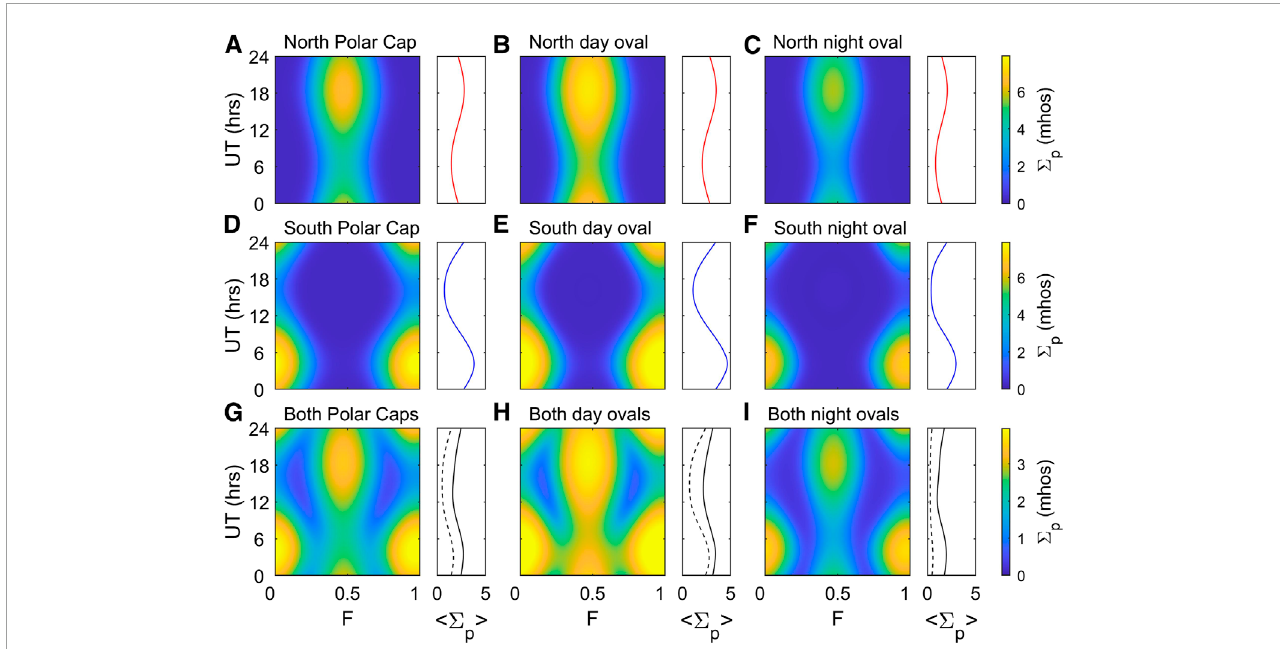
FIGURE 6 Analysis of the effect of pole motions on solar EUV-generated, height-integrated ionospheric Pedersen conductivity, computed using the dependence on solar zenith angle by Ridley et al. (2004) and the eccentric dipole model of Earth’s magnetic field by Koochak and Fraser-Smith (2017) for the year 2016. The variations of mean Pedersen conductivity are color-coded as a function of fraction of the year ( F , horizontal axis) and Universal Time ( UT , vertical axis). To the right of each color plot is a plot of the mean height-integrated Pedersen conductivity ⟨Σ p ⟩ (averaged over all times-of-year, F ) as a function of UT . Plots are for three regions (see text for full definitions): the left-hand column (part (A,D,G) ) is for the polar cap, the middle column (part (B,E,H) ) for the dayside auroral oval and the right-hand column (part (C,F,I) ) for the nightside auroral oval. The top row is for the northern hemisphere, the middle row for the southern hemisphere and the bottom row for the average of both hemispheres. The dashed black lines in the bottom row of ⟨Σ p ⟩ - UT plots show the minimum value at that UT